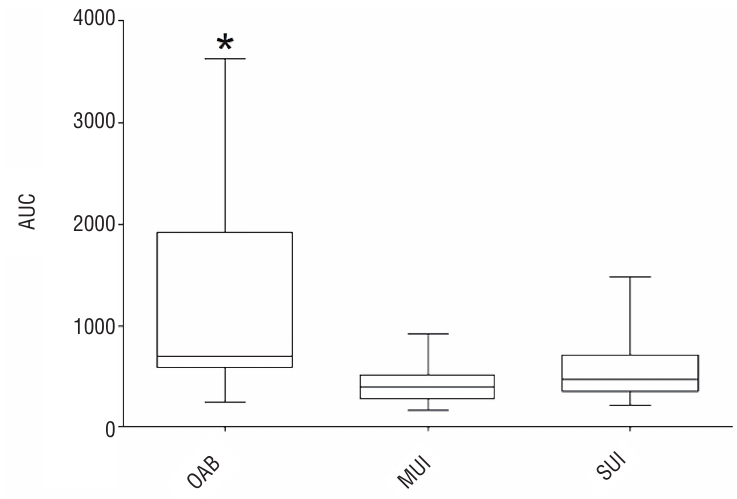
Figure 4 - Area under the curve of cUPP in patients with OAB, MUI and SUI, applied trapezoidal rule calculated from min.